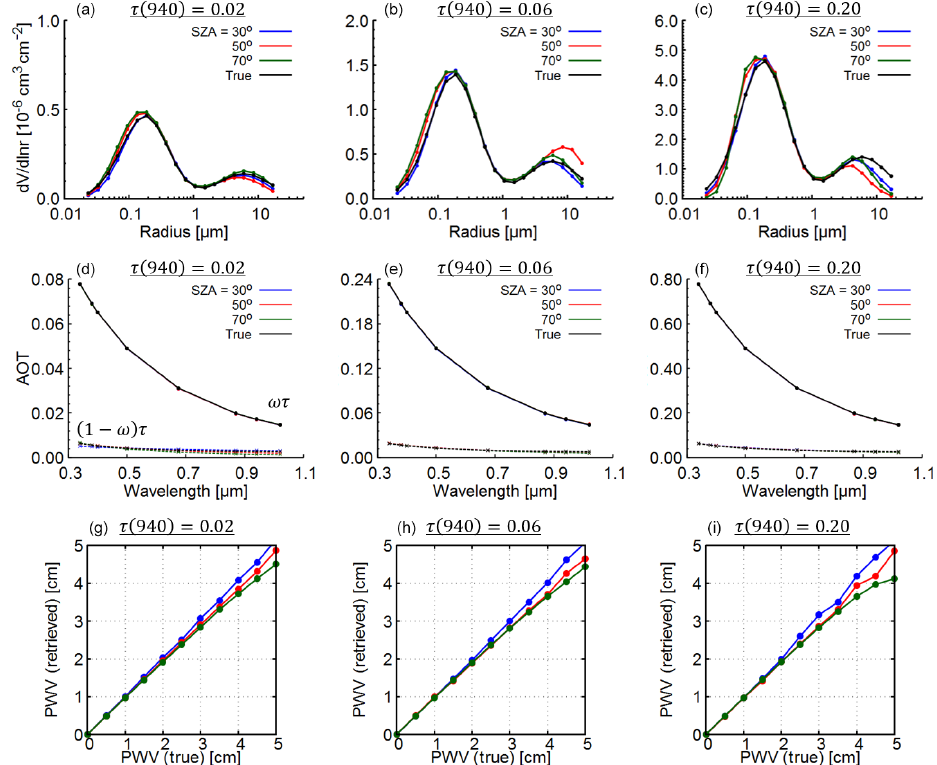
Figure 11. Retrieval results from simulated data for continental-average aerosol. The top row is the volume size distribution; the middle row is the scattering and absorption parts of aerosol optical thickness; and the bottom row is a comparison of the true and retrieval values of PWV. Blue, red, and green lines are the retrieval results at SZA = 30, 50, and 70 ◦ , respectively. The black line is the true value. Note that the blue, red, green, and black lines in the middle row